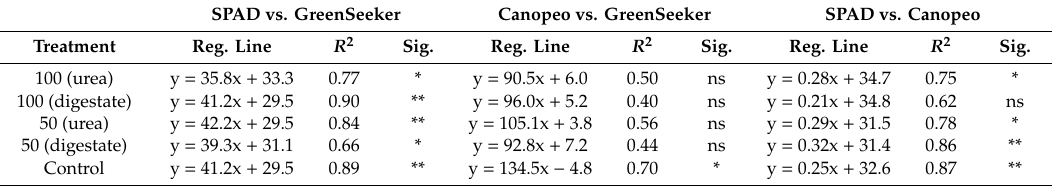
Table 3. Lineal regression, coe ffi cient of determination ( R 2 ), and statistical hypothesis testing ( p -value) for the interaction between di ff erent POSs (SPAD-502, GreenSeeker, and Canopeo App.) and N